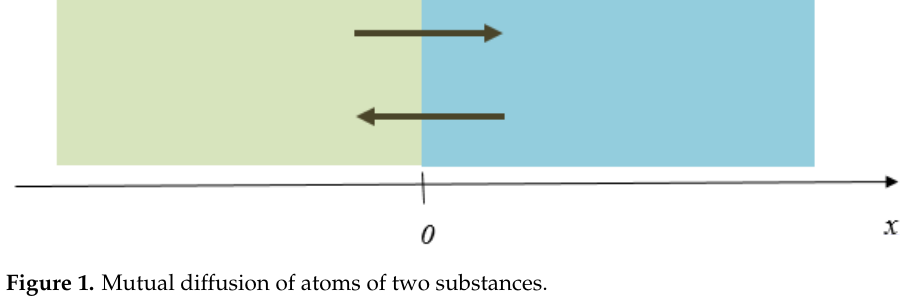
Figure 1. Mutual diffusion of atoms of two substances.